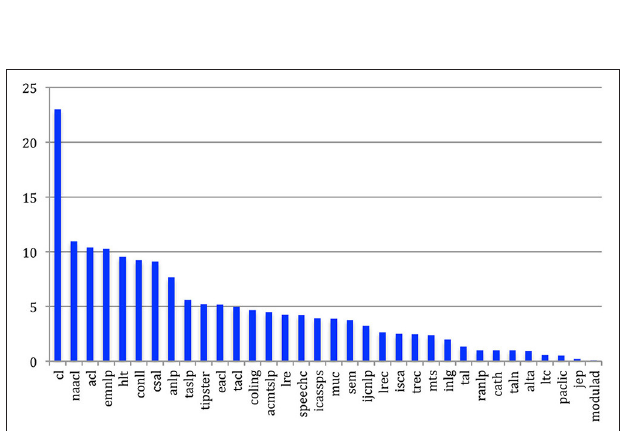
FIGURE 54 | Mean degree of papers being cited for the 34